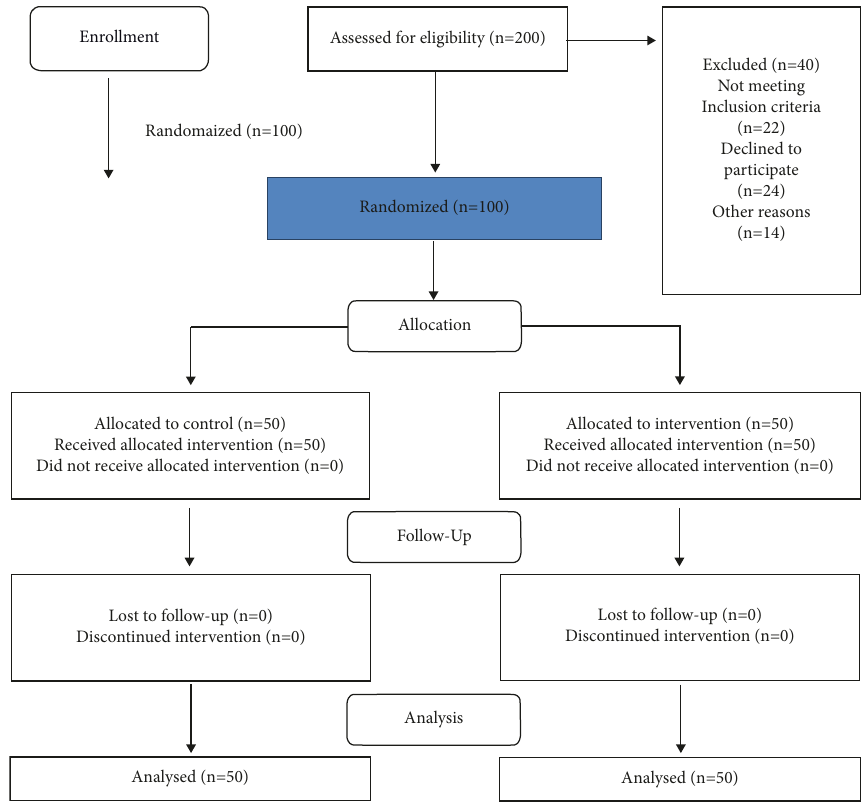
Figure 1: The study flow